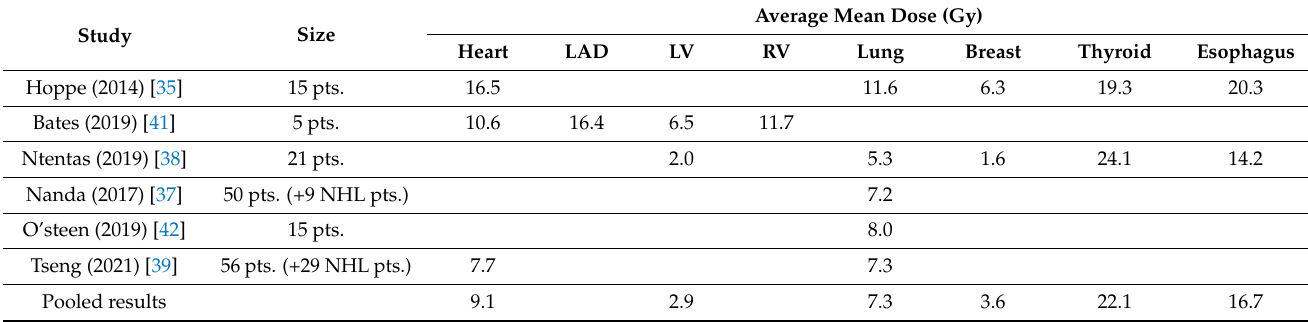
Table 2. Published dosimetric data (2014–2021) on radiation exposure to organs-at-risk for Hodgkin lymphoma (HL) patients treated with proton therapy. Pts: patients. LAD: left anterior descending coronary artery. LV: left ventricle. RV: right ventricle. Nanda et al. [37] and Tseng et al. [39] included non-Hodgkin lymphoma (NHL) patients in their studies. Grey areas: dosimetric data not